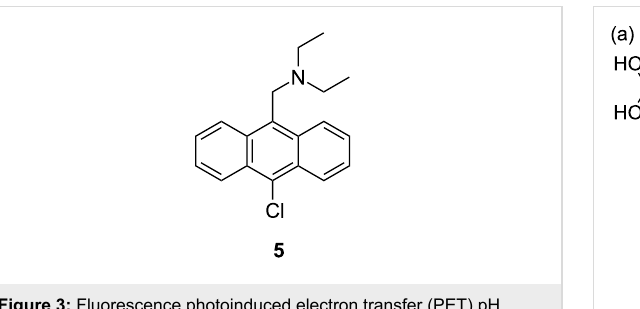
Figure 3: Fluorescence photoinduced electron transfer (PET) pH sensor developed by A. P. De Silva.